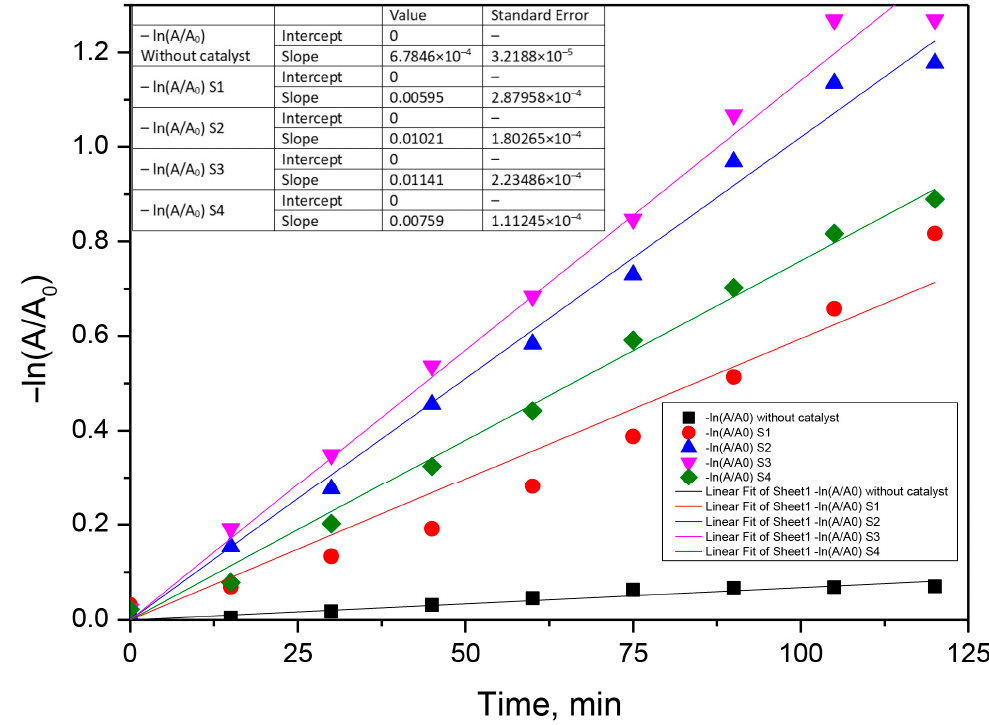
Figure 11. Fits of the pseudo-first-order kinetic model for the photocatalytic ceftriaxone degradation using the S1–S4 photocatalyst (0.05 g ‧ L − 1 , ceftriaxone concentration 0.05 g ‧ L − 1 ).